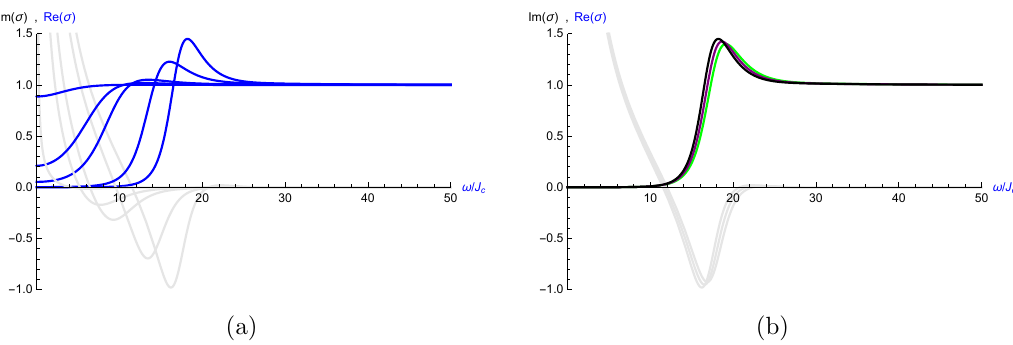
Figure 7. Plots of Real and Imaginary part of conductivity (cid:27) vs frequency !=J c , at zero chemical potential, when (cid:12) = 0. Here J c is the critical value source at which the superconductor phase begins to exist. In (a) we have (cid:12)xed the Lagrangian parameters to (cid:11) 1 = (cid:11) 2 = 0 : 1, and (cid:21) = 0 : 66, and we have increased J starting from J c . We notice that at large values of J , magnitude of the gap in the conductivity plot saturates and becomes maximal. In (b) we have chosen the parameters (cid:11) 1 = 0 : 1, (cid:11) 2 = 0 : 1, (cid:21) = 0 : 64 ; 0 : 65 ; 0 : 66 and we have (cid:12)xed the value of the source J , to some large value